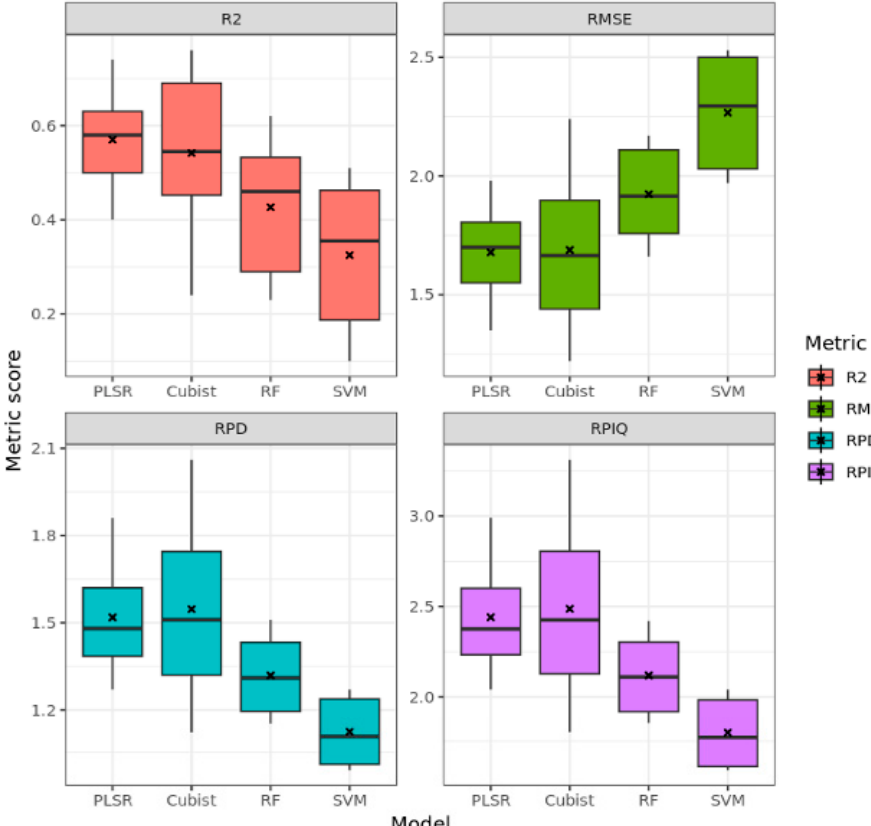
Figure 10. Box plots for the accuracy metrics for PRISMA estimations of OM with the use of the PLSR, Cubist, RF and SVM algorithms for all preprocessing methods.